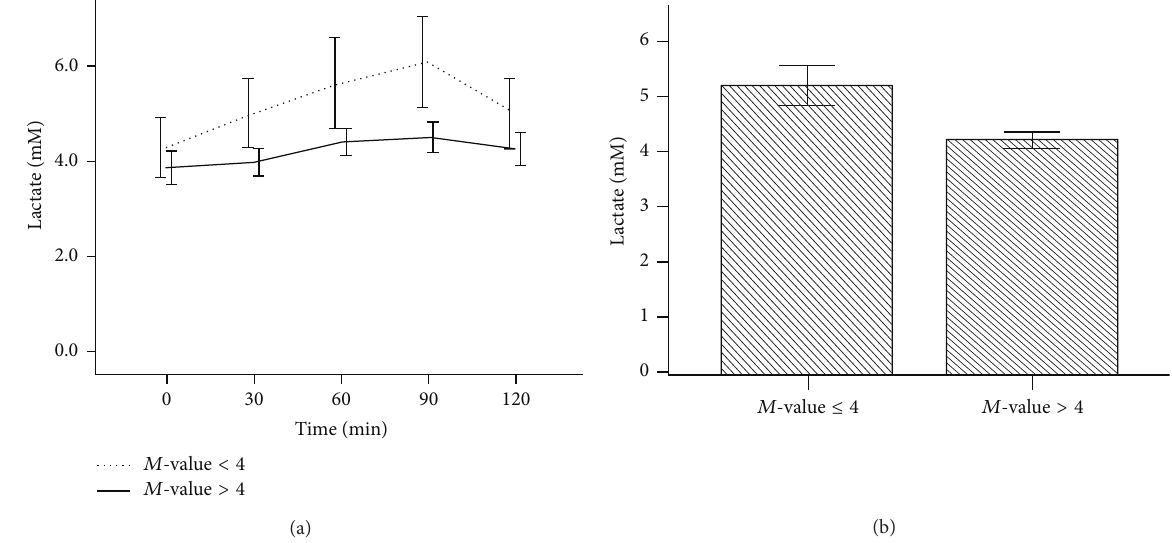
Figure 4: Plasma lactate values from OGTT according to 𝑀 -value. OGTT was based on 75 g oral glucose tolerance tested over 120min. 𝑀 - values represent the insulin resistance index at time 120 min of HIEC. Plasma lactate was measured as shown in Study Subjects. (a) showed a progressive increase in lactate during OGTT among patients with 𝑀 -value ≤ 4. The difference is not statistically different but did show a trend. (b) showed the mean total lactate among subjects with 𝑀 -value greater or less than 4. Participants having 𝑀 -values above 4 had significantly lower lactate levels ( 𝑃 < 0.01